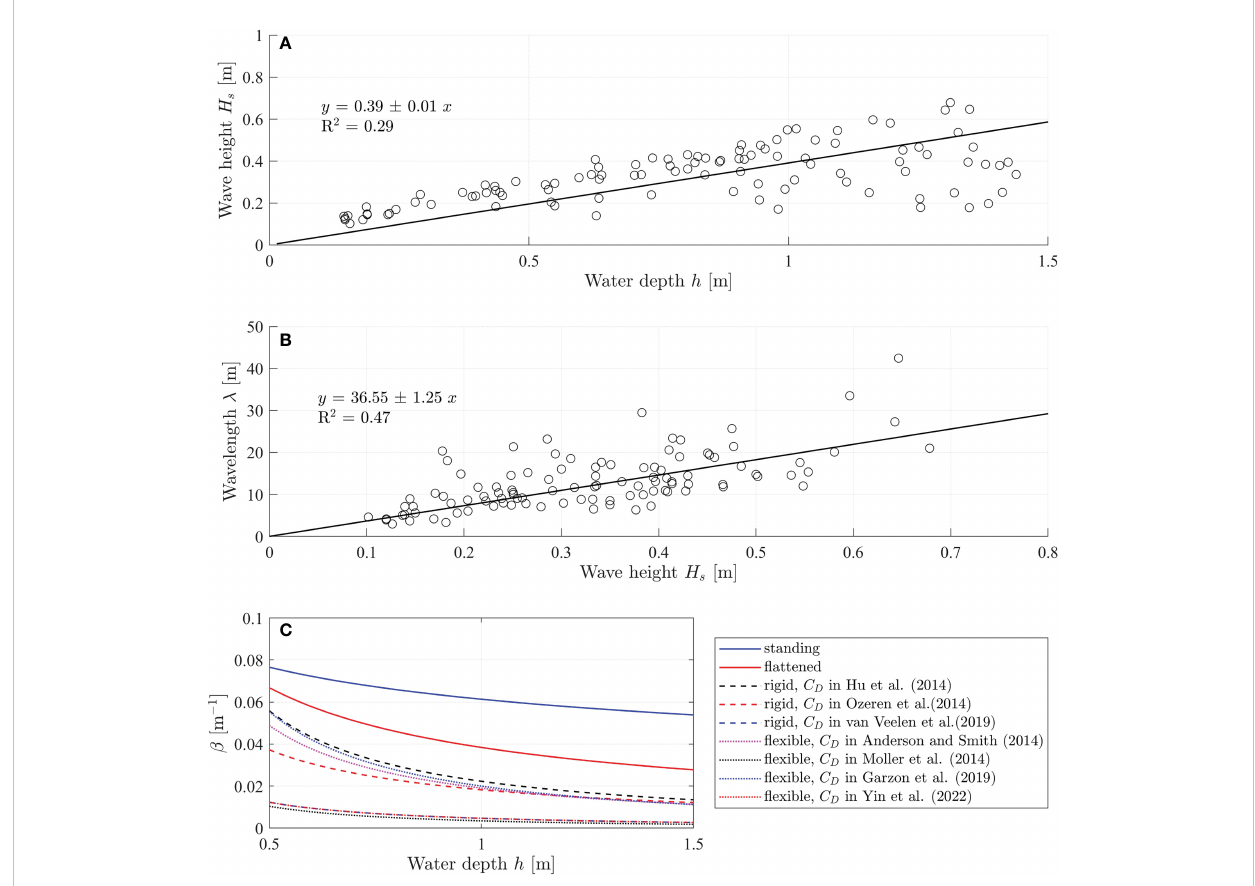
FIGURE 6 (A) Measured signi fi cant wave height ( H s ) and water depth ( h ) during September 10 to 17 in 2021 at Nanhui shore (Li et al., 2022). (B) Relation between wave length and wave height. (C) Comparisons between the wave damping coef fi cient by fully standing vegetation (solid blue line), fl attened vegetation (solid red line), and the 10 cm vertical unfolded part of the fl attened vegetation (dashed and dotted lines). The ( b ) by standing vegetation and fl attened vegetation were calculated based on the empirical formulas (4) and (5), respectively. The b by the 10 cm vertical